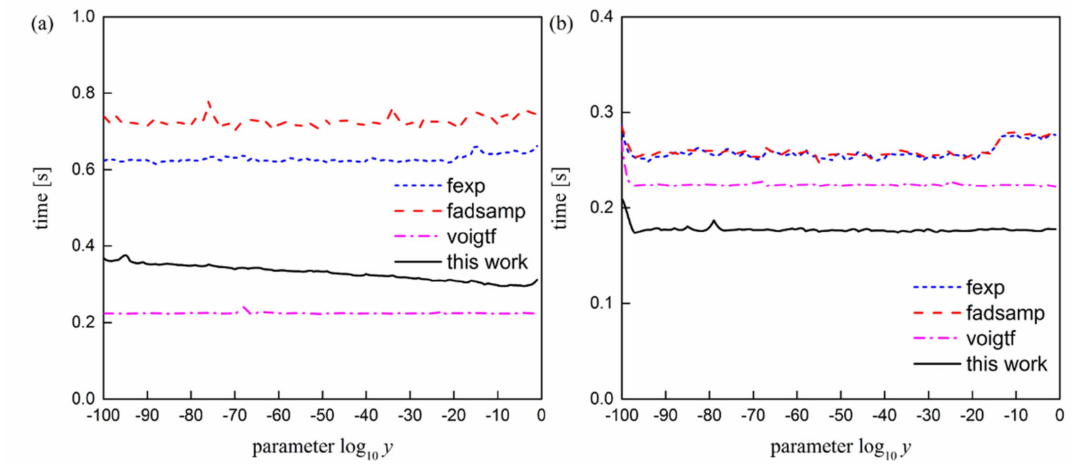
Figure 7. Execution time (s) per algorithm evaluation with 1 million random numbers in different y within the ( a ) internal domain | z | < 22 and ( b ) external domain 22 ≤ | z | ≤ 4000, respectively. The tests have been performed on a typical desktop computer Intel(R) Quad CPU with RAM 8.00 GB. (Since the “voigtf” algorithm can only calculate the real part of the complex error function, the calculation time is doubled here to compare the calculation speed with other